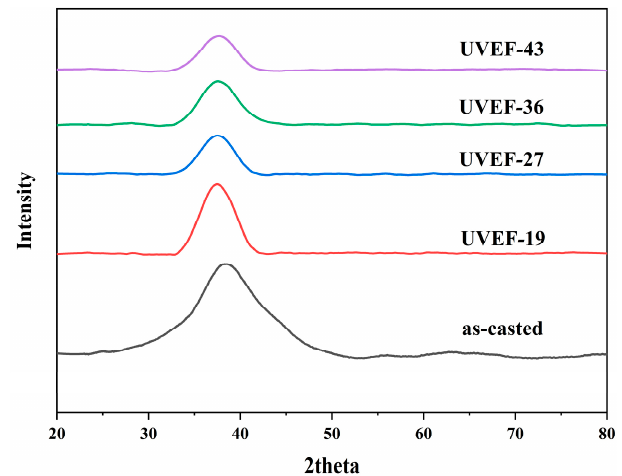
Figure 2. Comparison of the X ‐ ray diffraction (XRD) patterns of the as ‐ cast and ultrasonic vibration ‐ assisted elastic deformation (UVEF) ‐ treated samples.